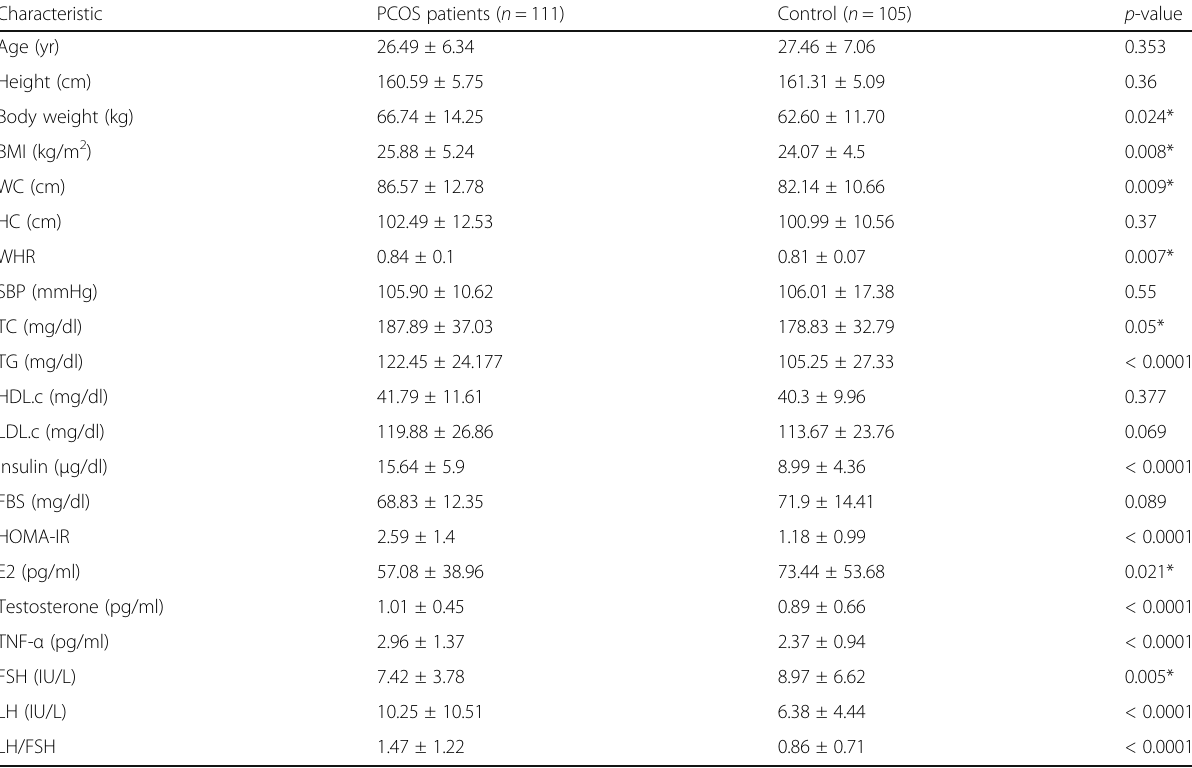
Table 1 Participants ’ Demographic, Anthropometric, Biochemical, and Hormonal Characteristics Characteristic PCOS patients ( n =